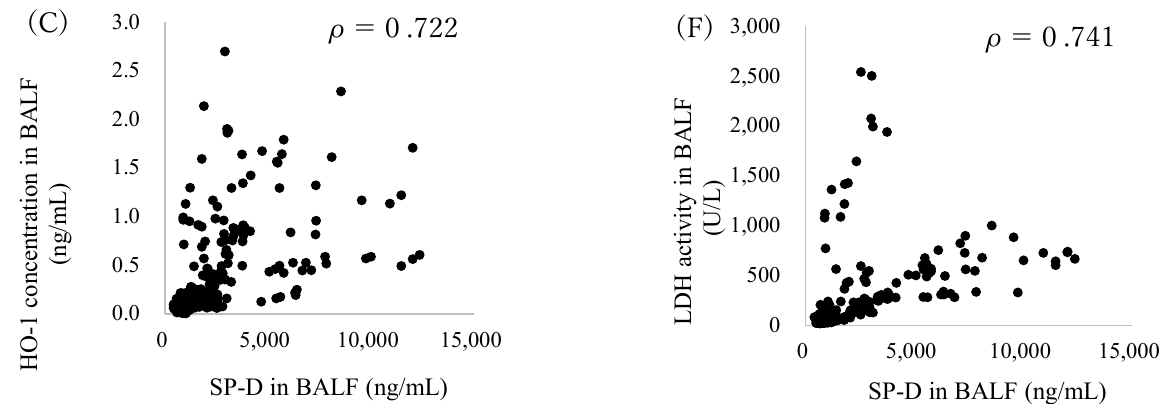
Figure 3. Relationship between SP-D concentration and inflammatory markers in BALF: ( A ) neutrophils (n = 250), ( B ) total cell (n = 250), ( C ) HO-1 (n = 250), ( D ) CINC-1 (n = 250), ( E ) CINC-2 (n = 250) and ( F ) LDH (n = 200) versus SP-D in BALF after intratracheal instillation of nanomaterials. Values of ρ are Spearman’s rank correlation coefficient for all the data.